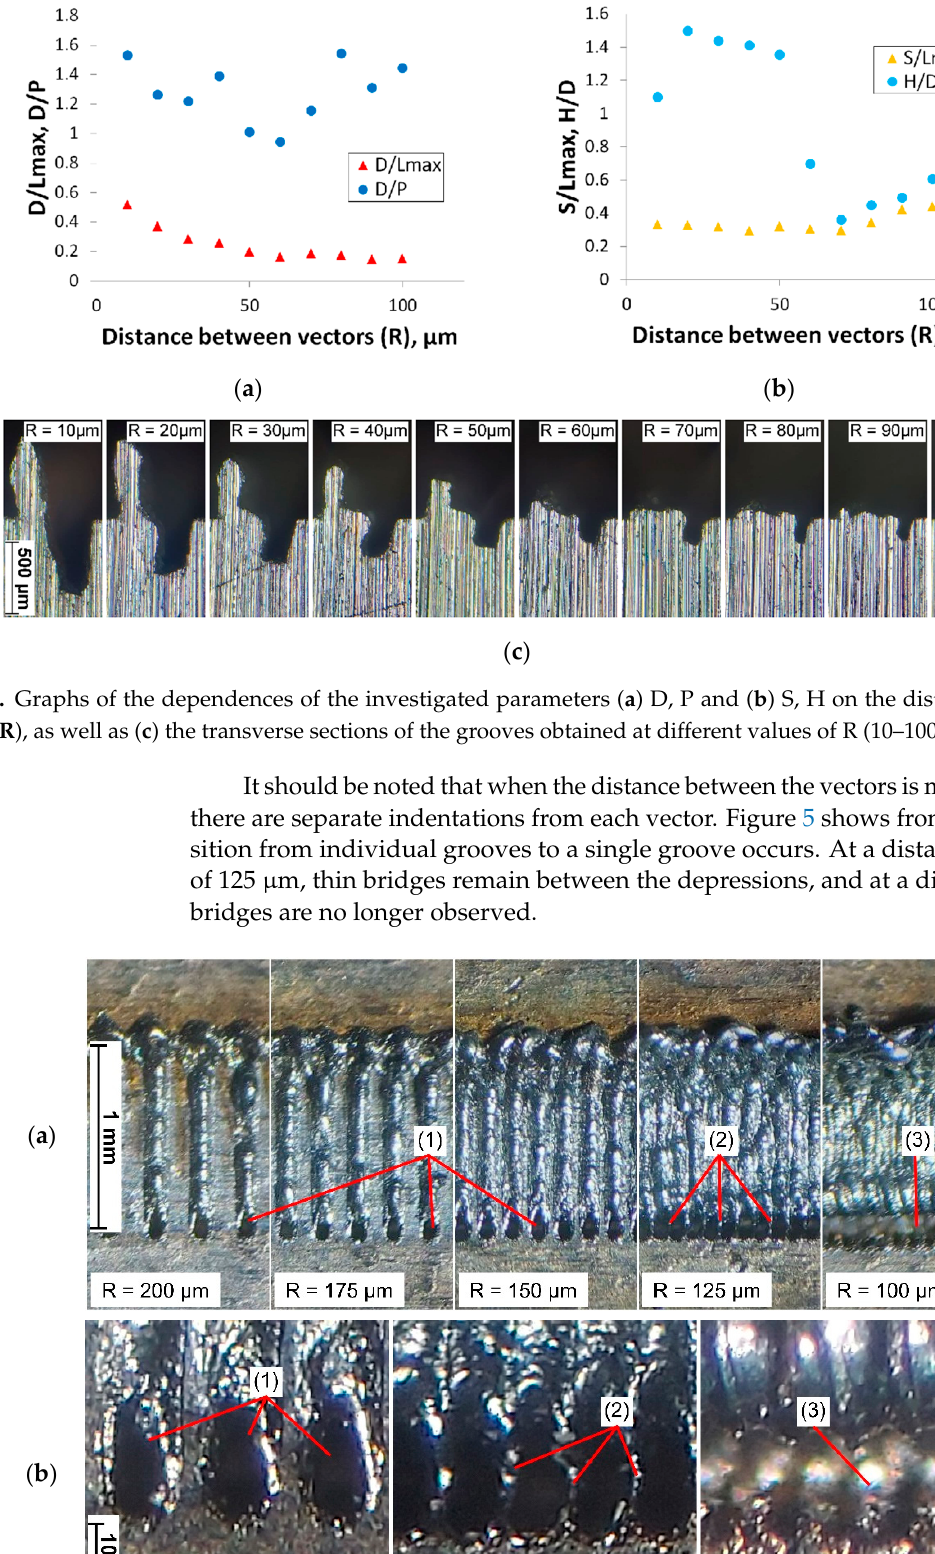
Figure 5. ( a ) View of grooves with different distances between vectors ( R ), where ( 1 ) are separate grooves, ( 2 ) are thin bridges between grooves and ( 3 ) is a single groove. ( b ) Close up view of grooves at different distances between vectors.